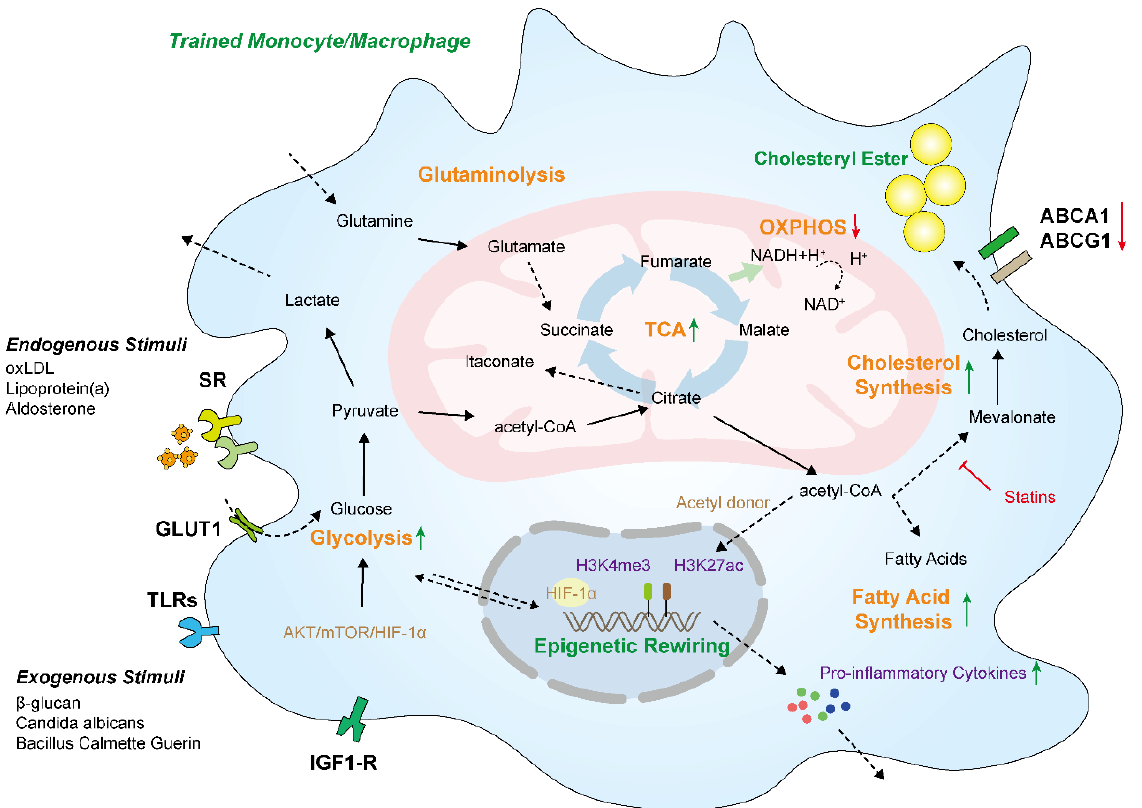
Figure 2. Schematic overview of metabolic and epigenetic reprogramming of monocytes/macrophages with innate immune memory during atherosclerosis. Monocytes/macrophages trained with endogenous or exogenous atherogenic stimuli induce the alteration of important metabolic processes, including glycolysis, oxidative phosphorylation (OXPHOS), the tricarboxylic acid (TCA) cycle, fatty acid synthesis, cholesterol synthesis, and glutaminolysis. These processes subsequently contribute to epigenetic rewiring (histone modifications) at the promoters of a series of genes. Trained monocytes/macrophages exhibit a proinflammatory phenotype by increasing the production of proinflammatory cytokines. IGF1 ‐ R, insulin ‐ like growth factor 1 receptors; TLR, Toll ‐ like receptor; SR, scavenger receptor; GLUT1, glucose transporter type 1; ABCA1, ATP ‐ binding cassette transporter A1; ABCG1, ATP ‐ binding cassette transporter G1.